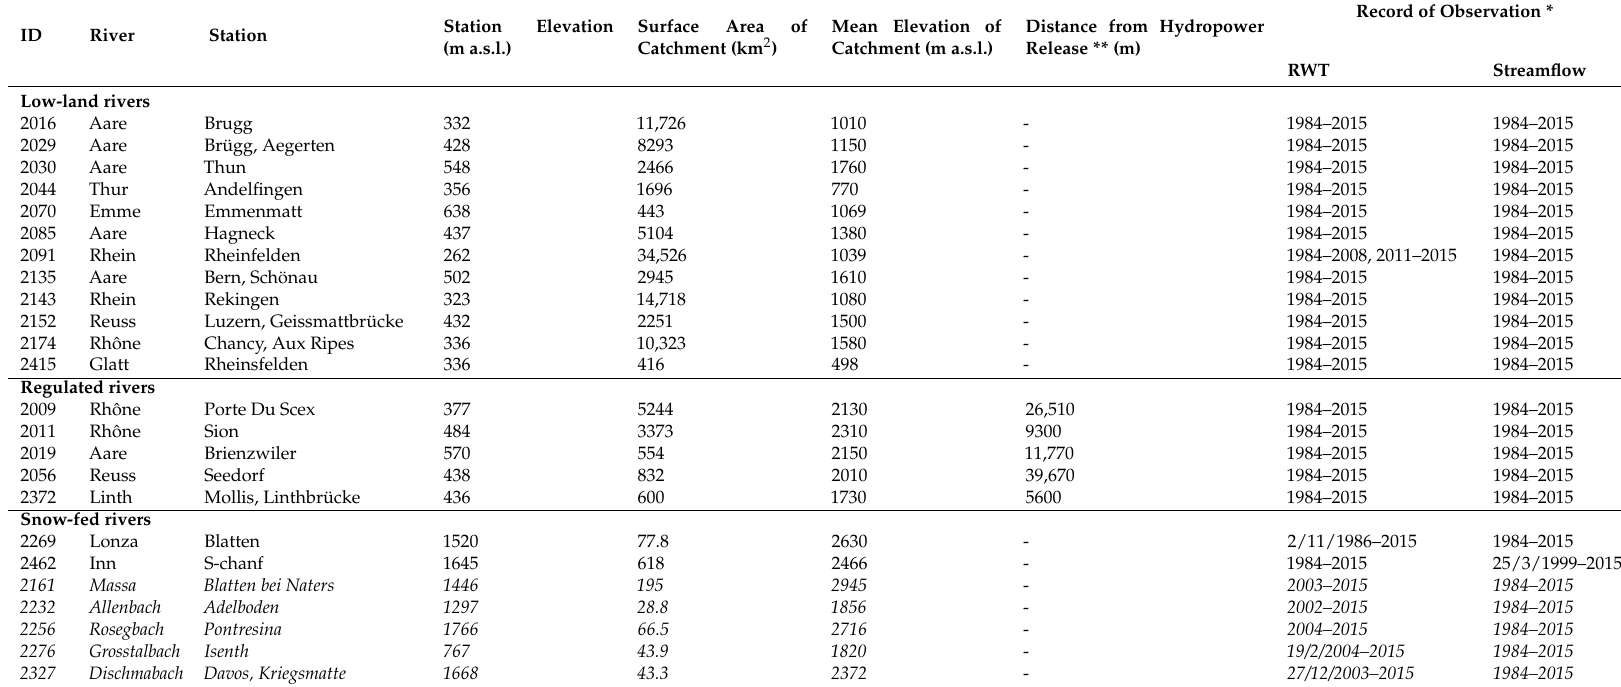
Table 1. Dataset of Swiss river stations used in the analysis. In italics we refer to snow-fed river stations with a RWT record shorter than 30 years, which were used only in the analysis presented in Figure